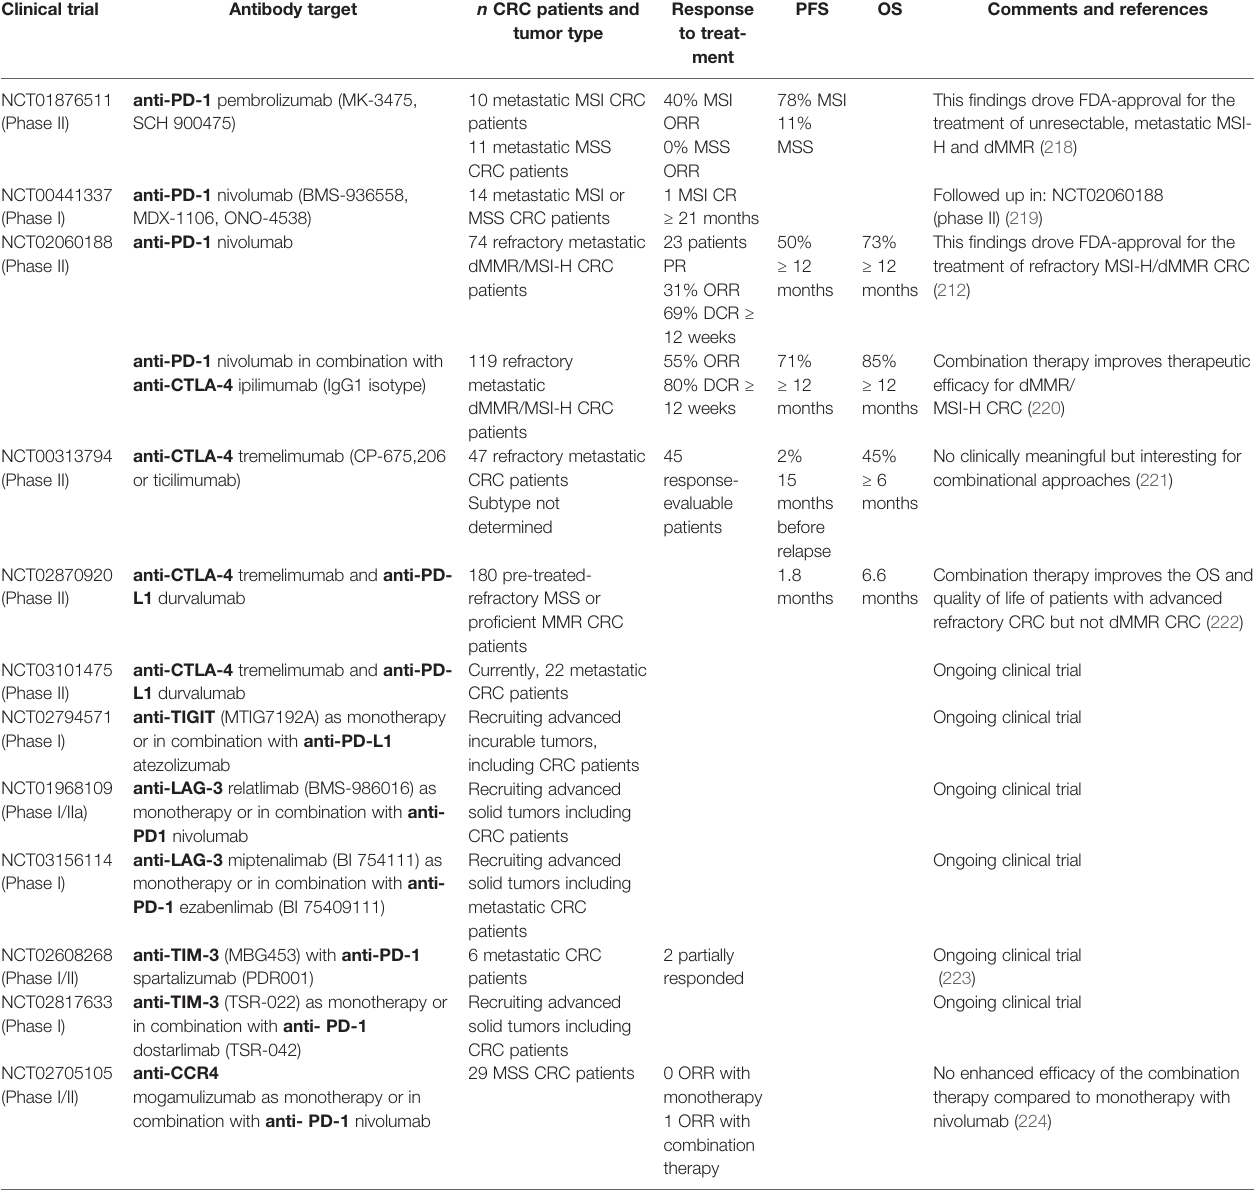
TABLE 2 | CRC clinical trials potentially targeting Treg cell populations. Clinical trial Antibody